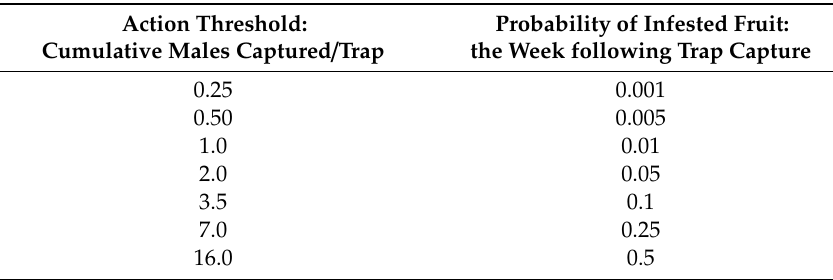
Table 5. Action thresholds for cumulative male D. suzukii per trap and the expected probability of infestation the week following last trap capture (1- probability estimated from the two-parameter Gamma density